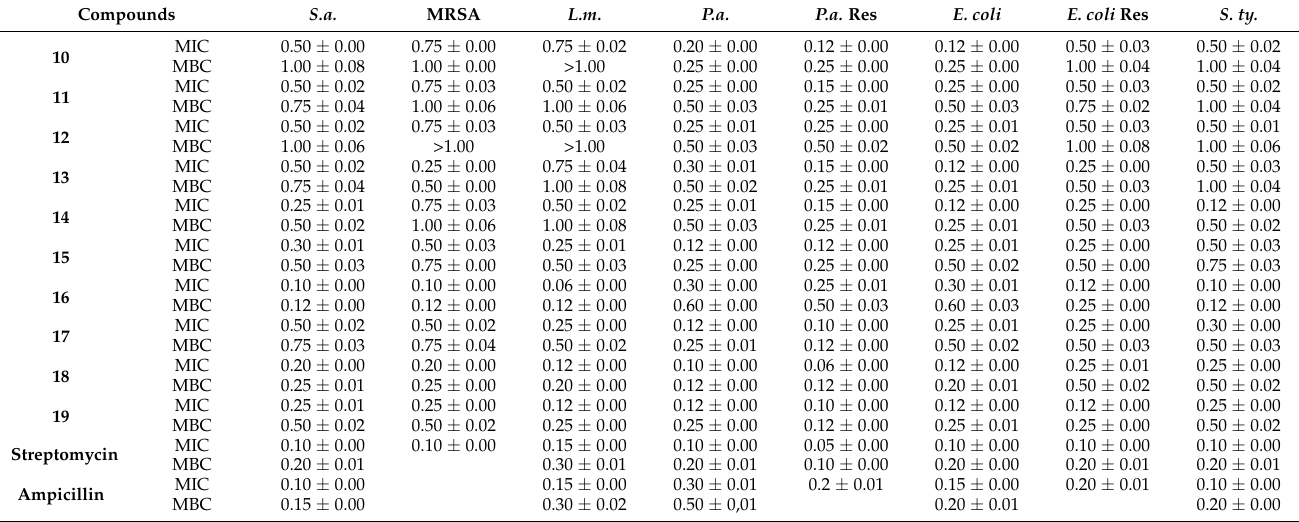
Table 4. Antibacterial activity of compounds 10 – 19 (MIC and MBC in